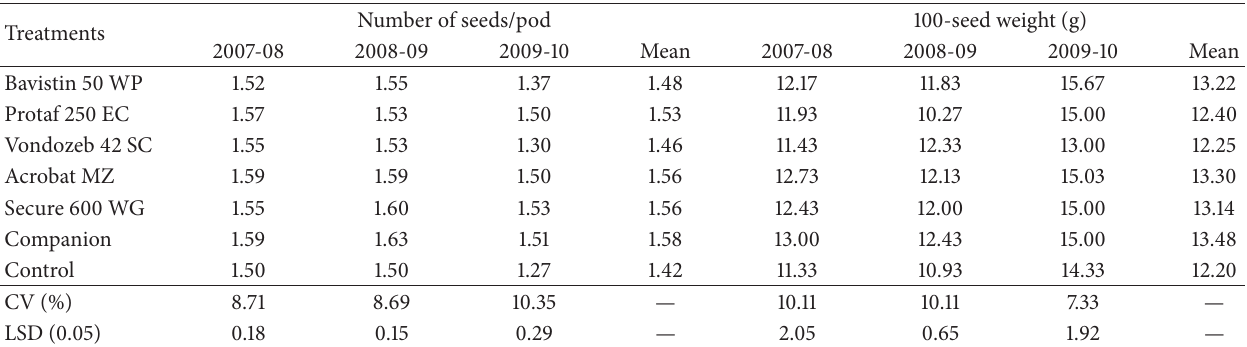
Table 3: Effect of fungicides with modes of action on number of seeds/pod and 100-seed weight in BGM susceptible chickpea variety “BARIchhola-1” under field conditions at Madaripur in Bangladesh during the postrainy season of 2007-08, 2008-09, and 2009-10. Treatments